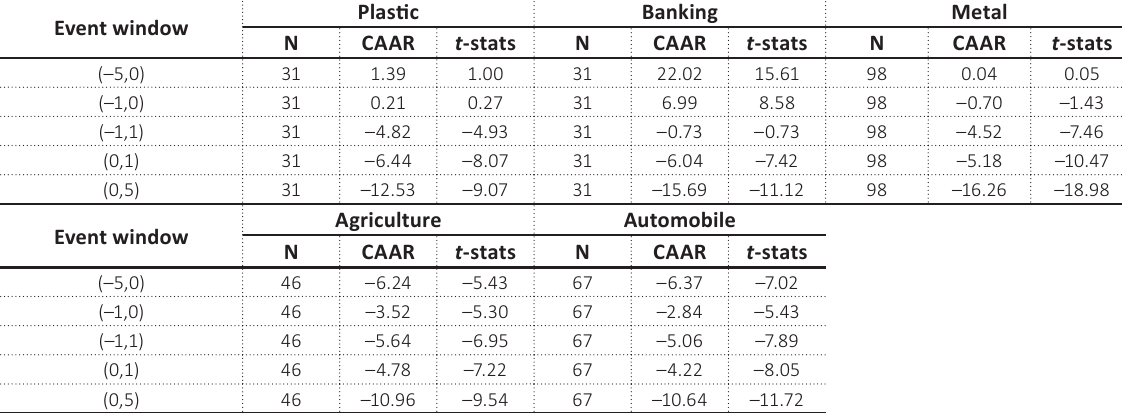
Table 4. CAAR for the plastic, banking, metal, agriculture, and automobile sectors to show the impact of the COVID-19 outbreak in different event windows Plastic Event window